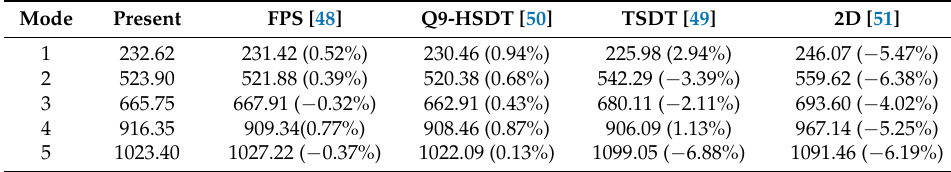
Table 2. First five frequencies